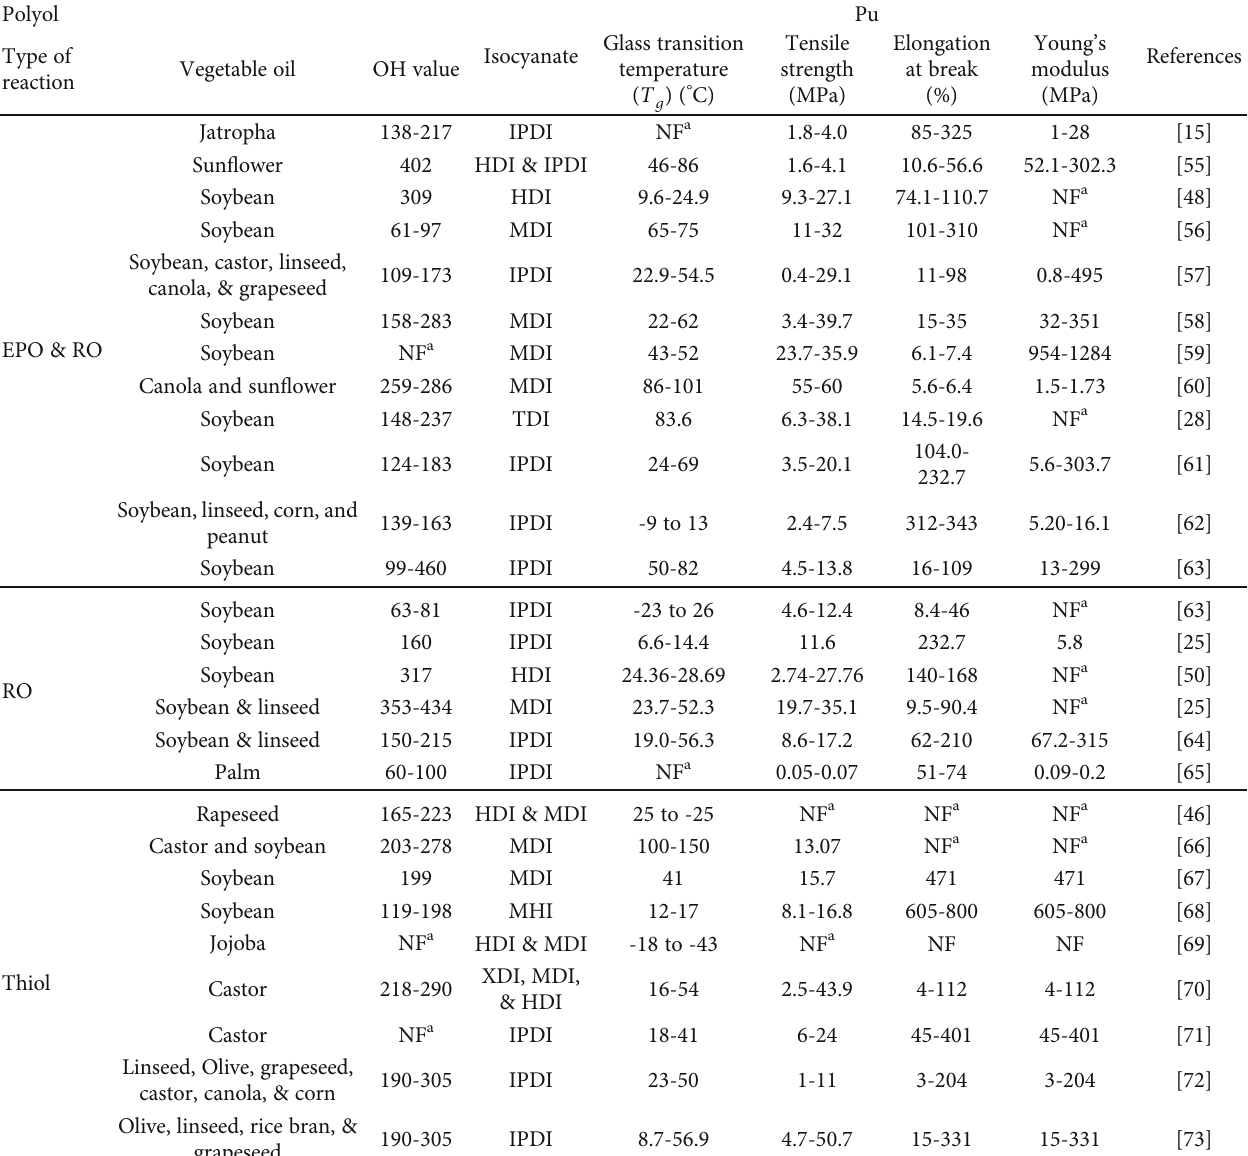
Table 4: Mechanical and thermal properties of biobased polyols produced from di ff erent vegetable oils. These polyols were then used to synthesize